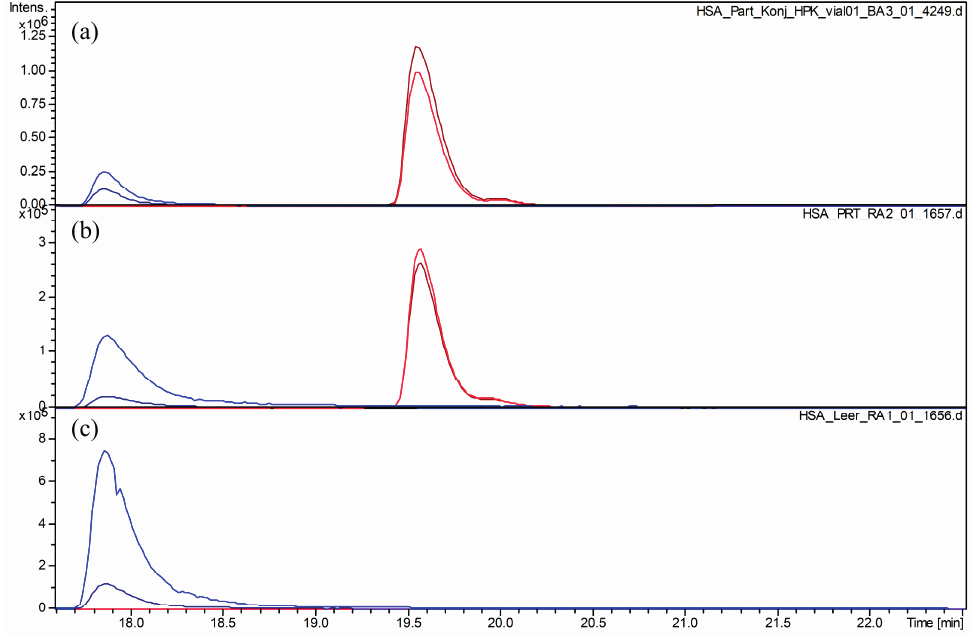
Figure 3. Extracted ion chromatograms for the (T21-41) 2 SS homodisulfide (blue plots) and for the monomeric (T21-41) + parthenolide (PRT) fragment (red plots). ( a ) HSA + PRT, Sample A; ( b ) HSA + PRT, Sample B; ( c ) HSA without PRT treatment. Extracted ion chromatograms for (T21-41) 2 SS ( m / z 811.8 [M+6H] 6+ , blue; 973.5 [M+5H] 5+ , dark blue) and for T21-41 + PRT ( m / z 671.1 [M+4H] 4+ , dark red; 894.5 [M+3H] 3+ ,